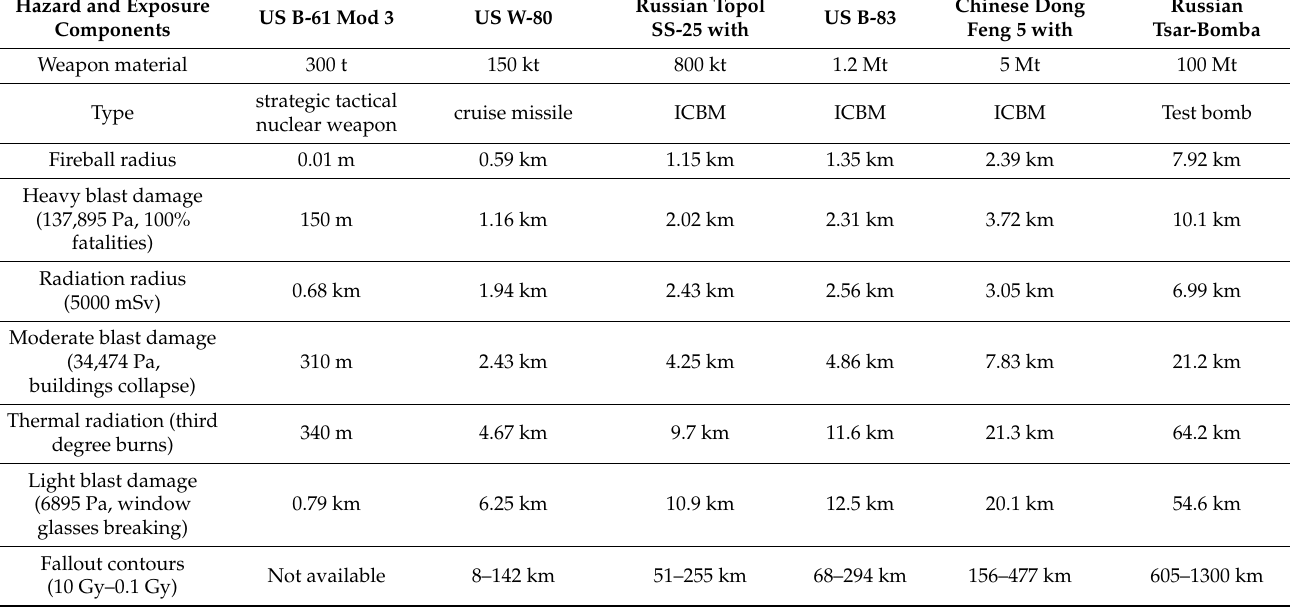
Table 1. Exposure buffer ranges selected from NUKEMAP (surface detonation, 50% fission